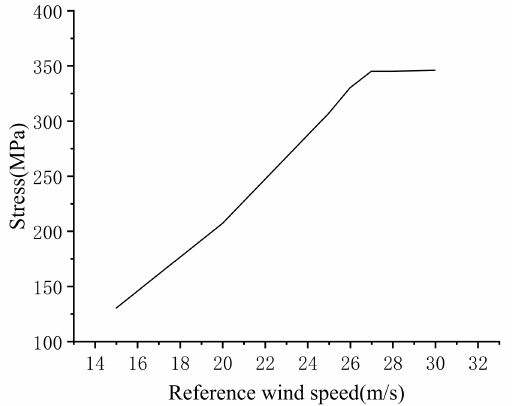
Figure 9. Stress nephogram of the failure member (V10 = 30 m/s).